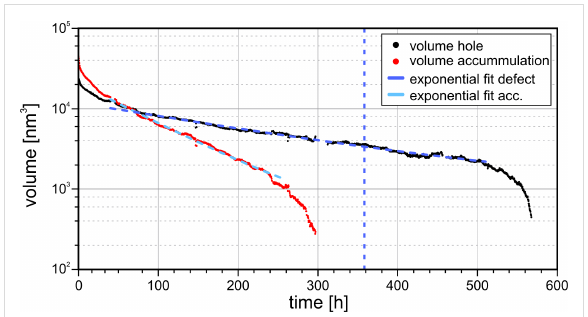
Figure 7: Time evolution of both defect and accumulation volume. After an initial settling time the logarithmically scaled size values show a linear behavior, which corresponds to an exponential decrease (see solution of differential Equation 5). The dashed blue vertical line corre- sponds to the point after which the relative humidity was increased linearly from RH = 12.9% to 19.9% until complete filling. The exponen- tial behavior is not affected. When the structure volumes fall below a certain size (accumulation: t > 250 h, hole: t > 510 h) the transport